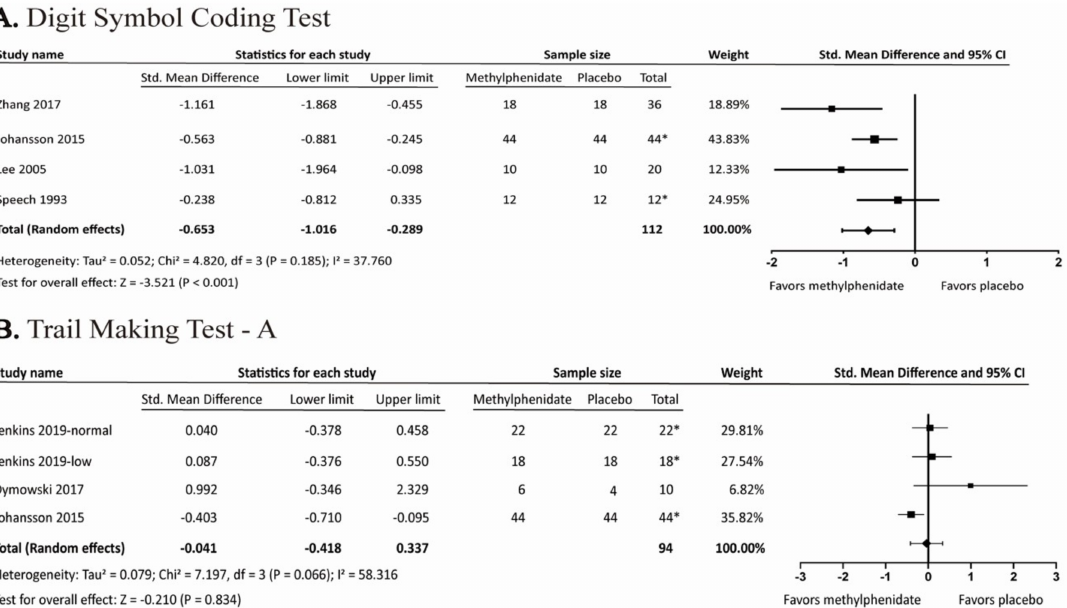
Figure 3. The e ff ects of methylphenidate in Choice Reaction Time. ( A ) Forest plot of methylphenidate in Choice Reaction Time, ( B ) Meta-regression analysis of heterogeneity with drug duration, ( C ) Meta-regression analysis of heterogeneity with mean age. *: crossover study.